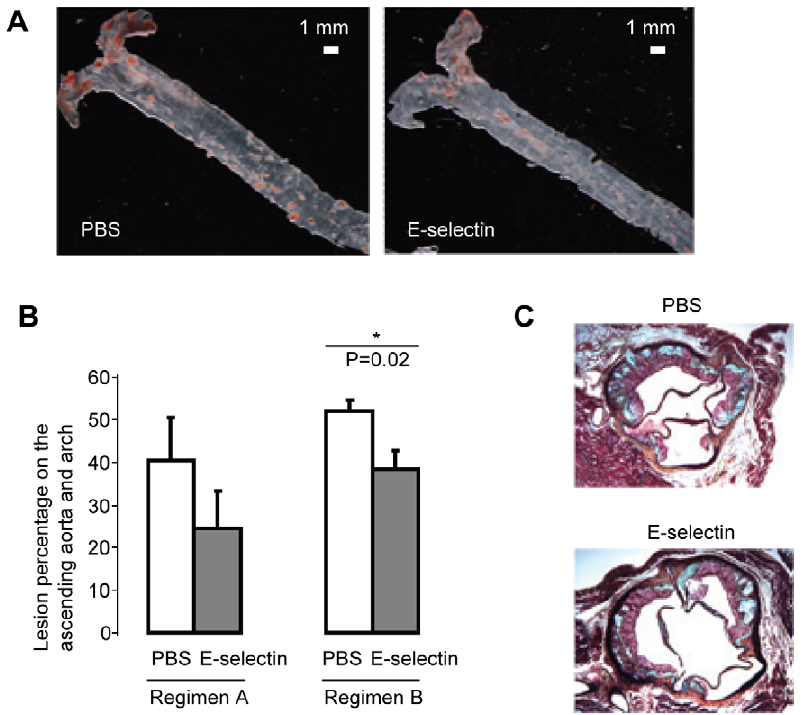
Figure 3. Intranasal delivery of E-selectin reduces atherosclerosis. Mice treated with regimen A (N=5 per group) or regimen B (N=10 per group) were processed En Face after 7 weeks on a high-fat diet. The lipid lesions in the aorta were stained with Sudan IV. (A) Representative photos illustrate the predominance of lesions in the aortic arch. (B) Quantification of lipid lesion on the ascending aorta and arch. In regimen B, pre- tolerization with E-selectin caused a significant 26.4% plaque reduction in the surface area of the ascending aorta and arch. (C) Movat staining of cross-sections of the aortic root in regimen B. The PBS and E-selectin groups showed similar degrees of pathology in the aortic roots. doi:10.1371/journal.pone.0020620.g003 PLoS ONE |